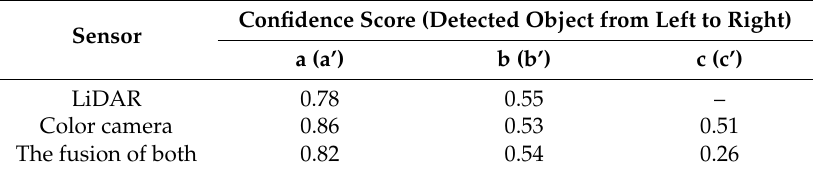
red. Table 1. Confidence scores obtained using different sensors.